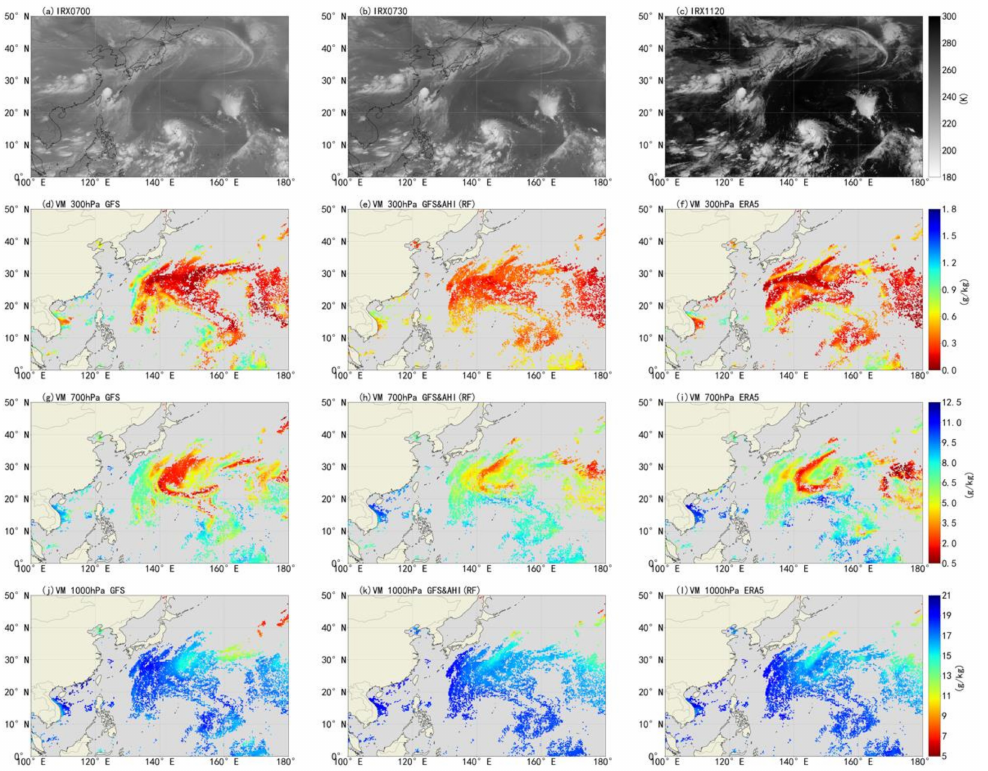
Figure 3. The brightness temperature patterns of ( a ) band 9 central at 6.9 µ m, ( b ) band 10 central at 7.3 µ m, and ( c ) band 9 central at 11.2 µ m at 00 UTC 5 July 2018, and the VM retrievals at 300 hPa, 700 hPa, and 1000 hPa, respectively, from ( d , g , j ) the GFS forecasts, ( e , h , k ) the RF-based algorithm and ( f , i , l ) the ERA5.